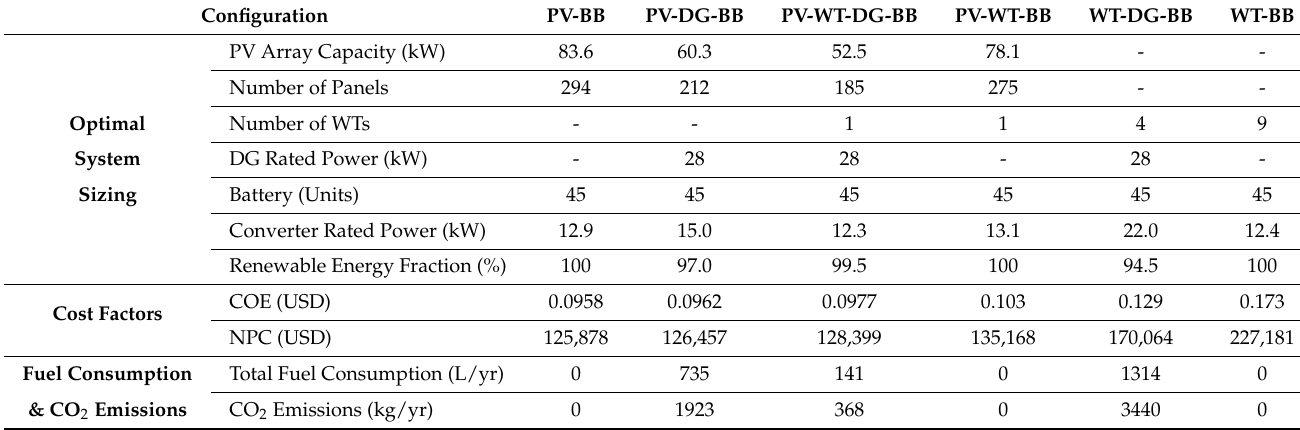
Table 15. Simulation Results for Wafra Cell Site—Case 1.